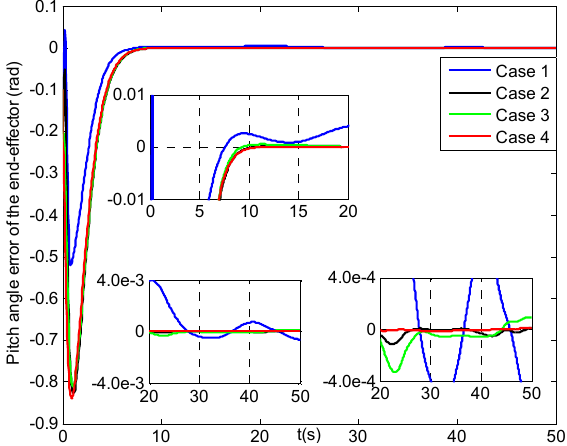
Figure 16. Pitch angle errors of the end − effector (four cases).